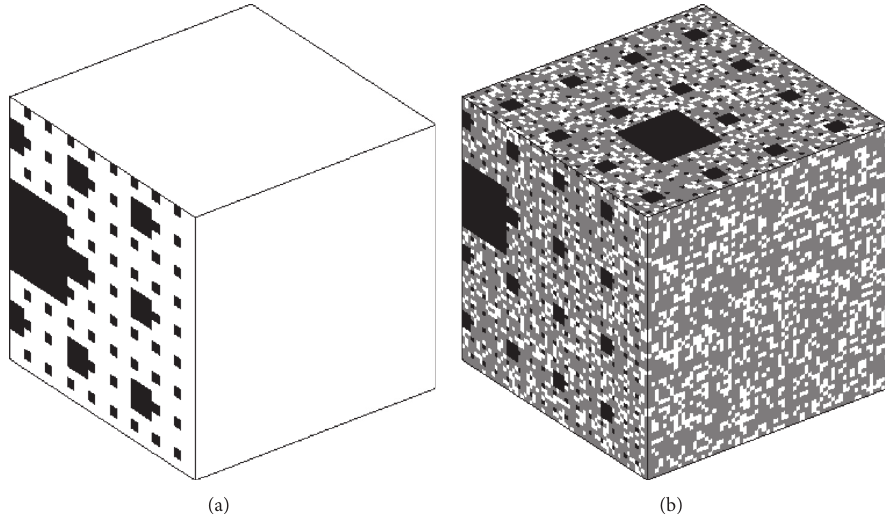
Figure 4: Realization of pore structure in cement paste (a) C-S-H gel structure ( 𝑛 low = 3 , 𝑖 low = 3 , 𝑏 low = 25 ) with element size of 0.004 𝜇 m; (b) capillary structure of cement paste ( 𝑛 upp = 4 , 𝑖 upp = 3 , 𝑏 upp = 62 , 𝛾 = 0.7115 ) with element size of 0.1 𝜇 m. Black denotes the pore phase, white denotes the solid phase, and gray denotes the C-S-H gel